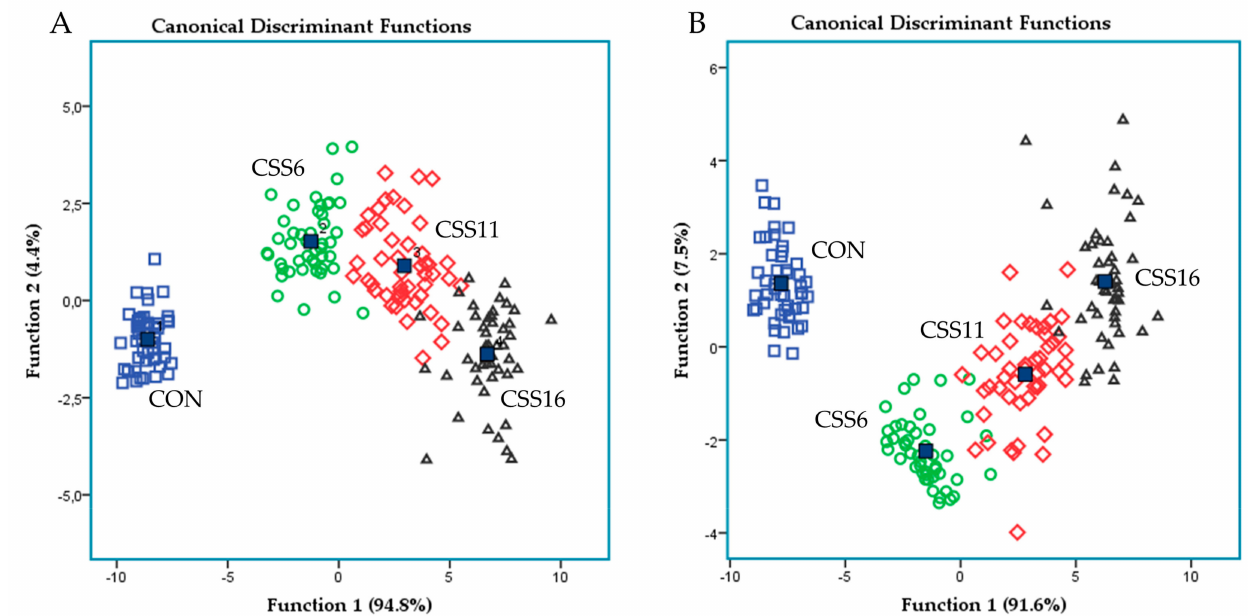
Figure 2. Discriminant plots separating ( A ) the four dietary treatments (CON; blue (cid:3) , CSS6; green CSS16; black (cid:52) ) according to pooled data of four sampling times (15th, 30th, 45th, and 60th experimental day) that entered independent variables of milk individual fatty acids together, grouped fatty acids, fatty acids health indices, and ∆ -9 desaturase indices and ( B ) discriminating the four dietary treatments (CON; blue (cid:3) , CSS6; green CSS16; black (cid:52) ) based on a step-wise